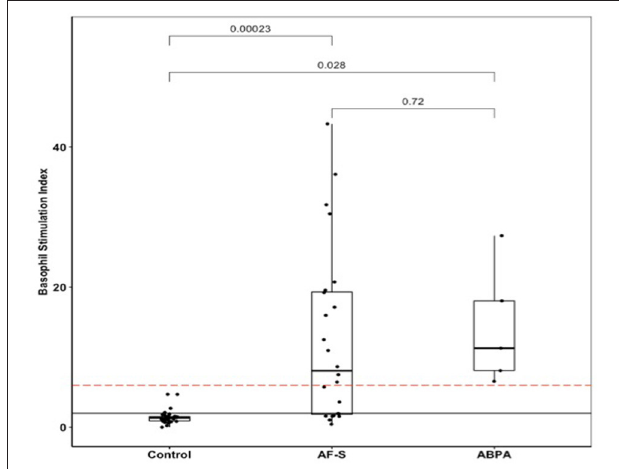
FIGURE 2 | BAT AF in ABPA, AF-sensitized (AF-S), or control patients. The solid black line shows the usual BAT positivity threshold (stimulation index = 2); the dotted red line shows the optimal BAT threshold (stimulation index = 6.55). ABPA, allergic bronchopulmonary aspergillosis; AF, Aspergillus fumigatus; AF-S, Aspergillus fumigatus-sensitized; BAT, basophil activation test.